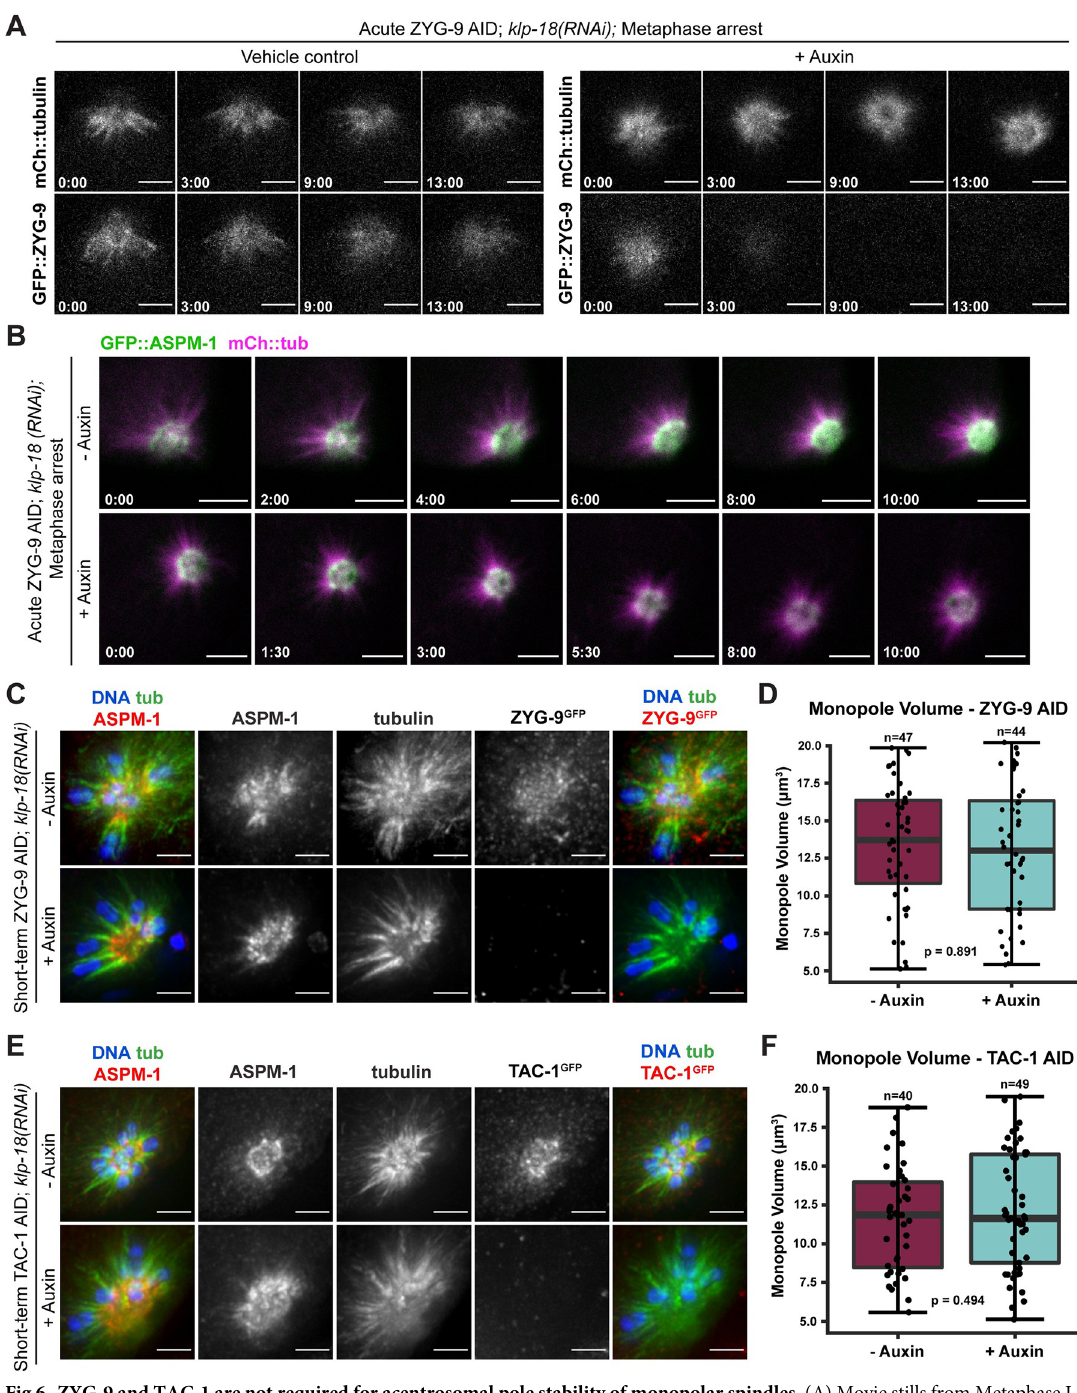
Fig 6. ZYG-9 and TAC-1 are not required for acentrosomal pole stability of monopolar spindles. (A) Movie stills from Metaphase I- arrested klp-18(RNAi)) oocytes expressing mCherry::tubulin and degron::GFP::ZYG-9 acutely treated with either vehicle (left, n = 3) or 100 μ M auxin (right, n = 3). Auxin treatment causes a rapid loss of ZYG-9 signal but the structure of the monopolar spindle does not noticeably change. Bars = 5 μ m. Timestamp = min:sec. (B) Movie stills from Metaphase I-arrested klp-18(RNAi)) oocytes expressing mCherry::tubulin, degron::GFP::ZYG-9, and GFP::ASPM-1. Whether oocytes were dissected into vehicle (left, n = 5) or 100 μ M auxin (right n = 5) solutions, the integrity of the monopole (as seen by ASPM-1) was not compromised; pole morphology and spindle structure remains stable throughout the timelapses. Bars = 5 μ m. Timestamp = min:sec. (C-F) Examination of pole morphology following ZYG-9 or TAC-1 depletion. (C, E) IF imaging of oocyte spindles in the ZYG-9 AID strain (C) or the TAC-1 AID strain (E) in klp-18(RNAi) conditions; shown are DNA (blue), microtubules (green), ZYG-9 or TAC-1 (stained with a GFP antibody; red, merge on the right), and